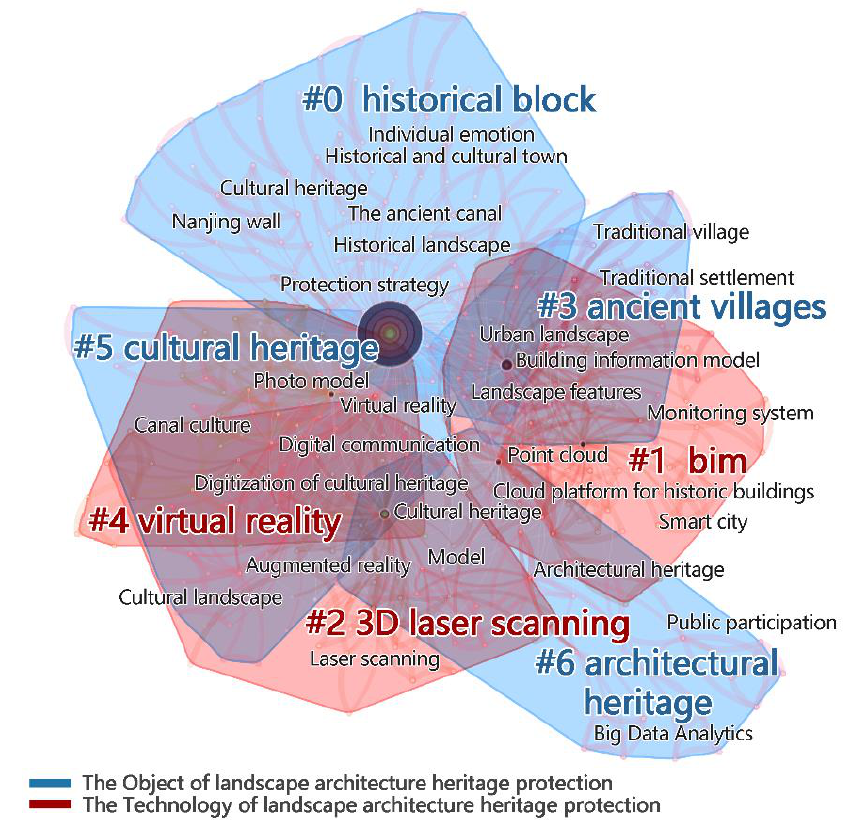
Figure 3. Keyword clustering diagram of digital landscape architecture heritage protection.